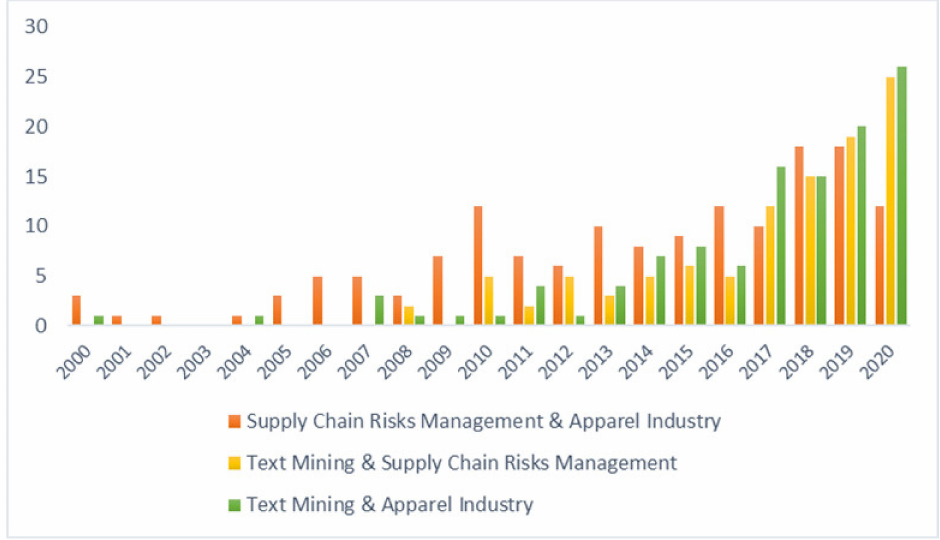
Figure 10. Overall trend of 370 original articles, based on the number of publications between the years 2000 and 2020, selected though SCOPUS and IEEE Xplore online libraries after applying search terms in Phase I, Phase II and Phase